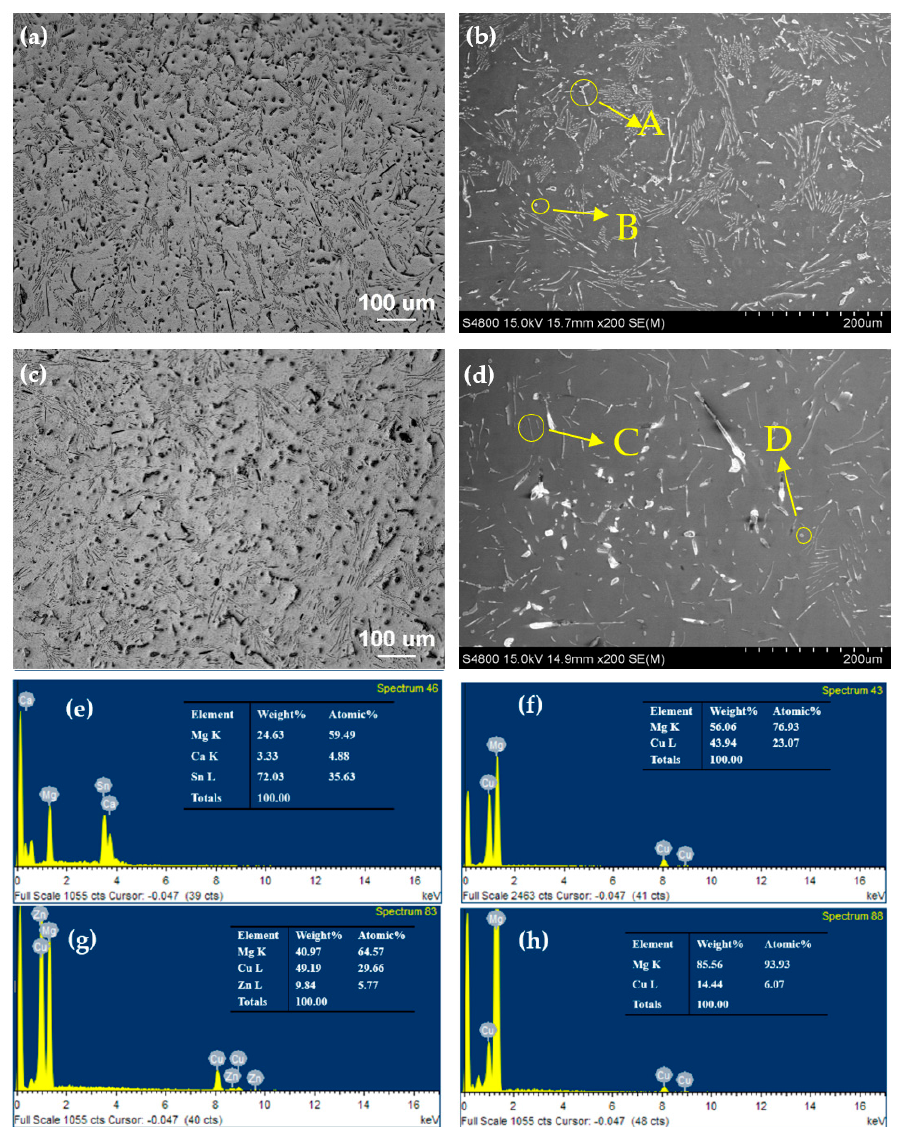
Figure 2. OM and SEM/EDS images of homogeneous TXC311 and TXCZ3111. ( a , b ) TXC311; ( c , d ) TXCZ3111; ( e , f ) represent point A and point B in Fig.( b ), respectively; ( g , h ) represent point C and point D in Fig.( d ), respectively.